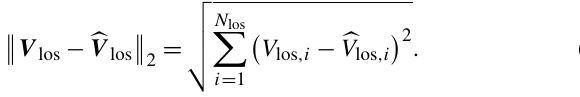
and model-simulated b V los where the error is defined as (cid:13) (cid:13) V los − b V los